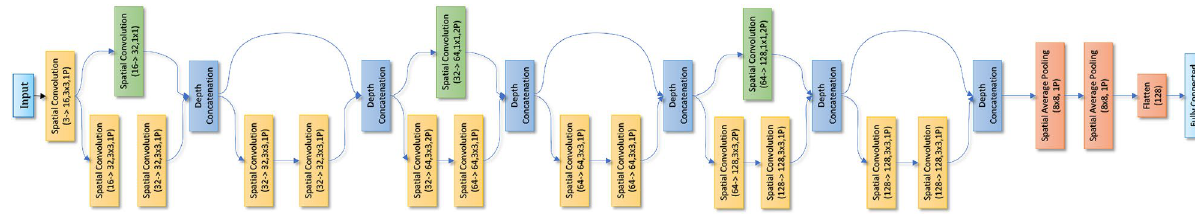
Figure 7. Architecture of the Wide ResNet-50-2 base model.